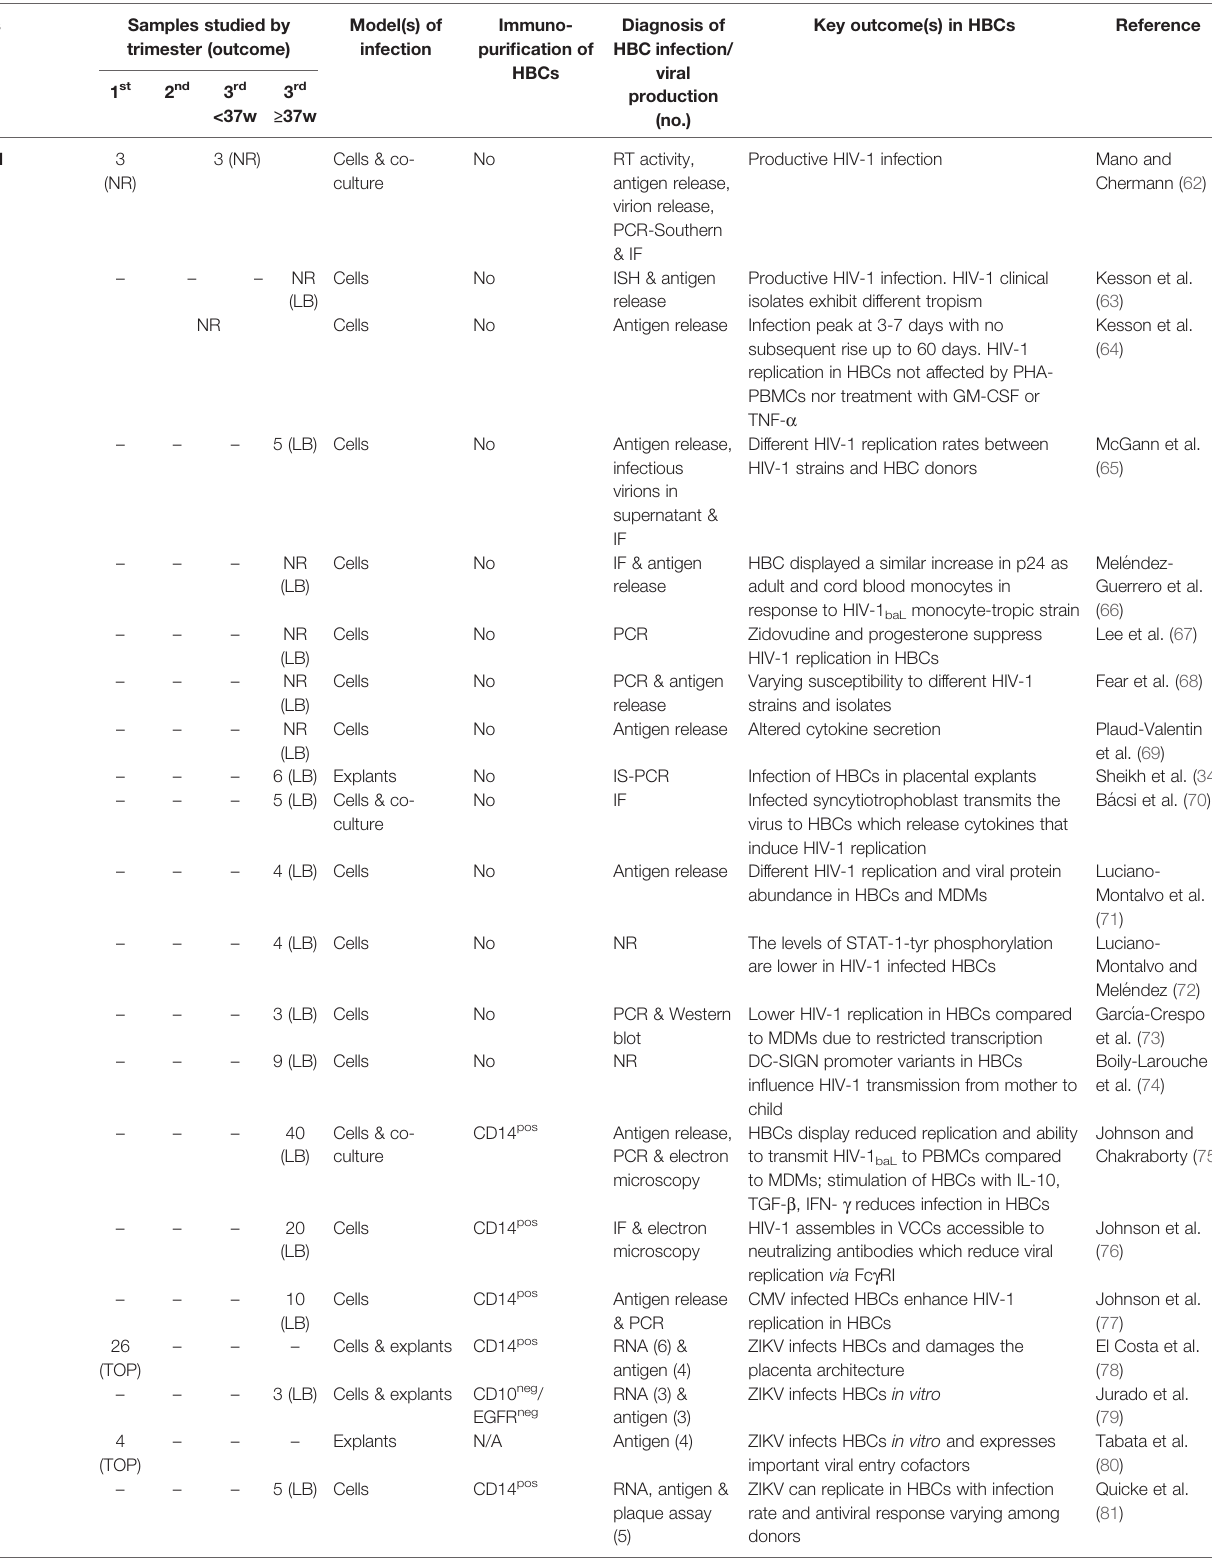
TABLE 2 | Hofbauer cells in in vitro studies of viral infection.